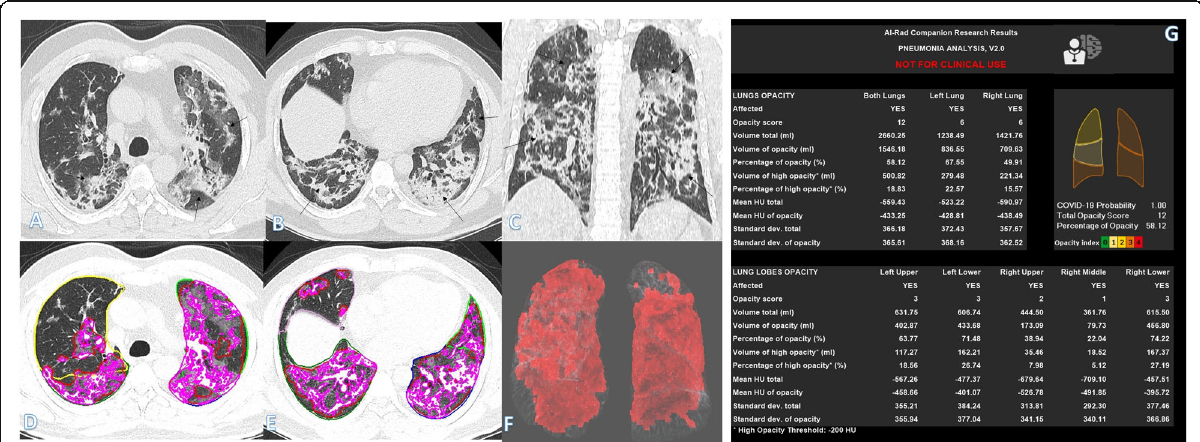
Fig. 6 A 46-year-old male with positive COVID-19 virus. CT chest shows diffuse bilateral confluent consolidation with air bronchogram, crazy- paving appearance, subpleural thickening with fibrosis, and organizing pneumonia pattern of COVID-19 (arrows in a – c ). Total severity score = 13. Quantitative analysis ( d – g ) by AI-Rad Companion Research CT Pneumonia Analysis was presented with the measured parameters seen in table